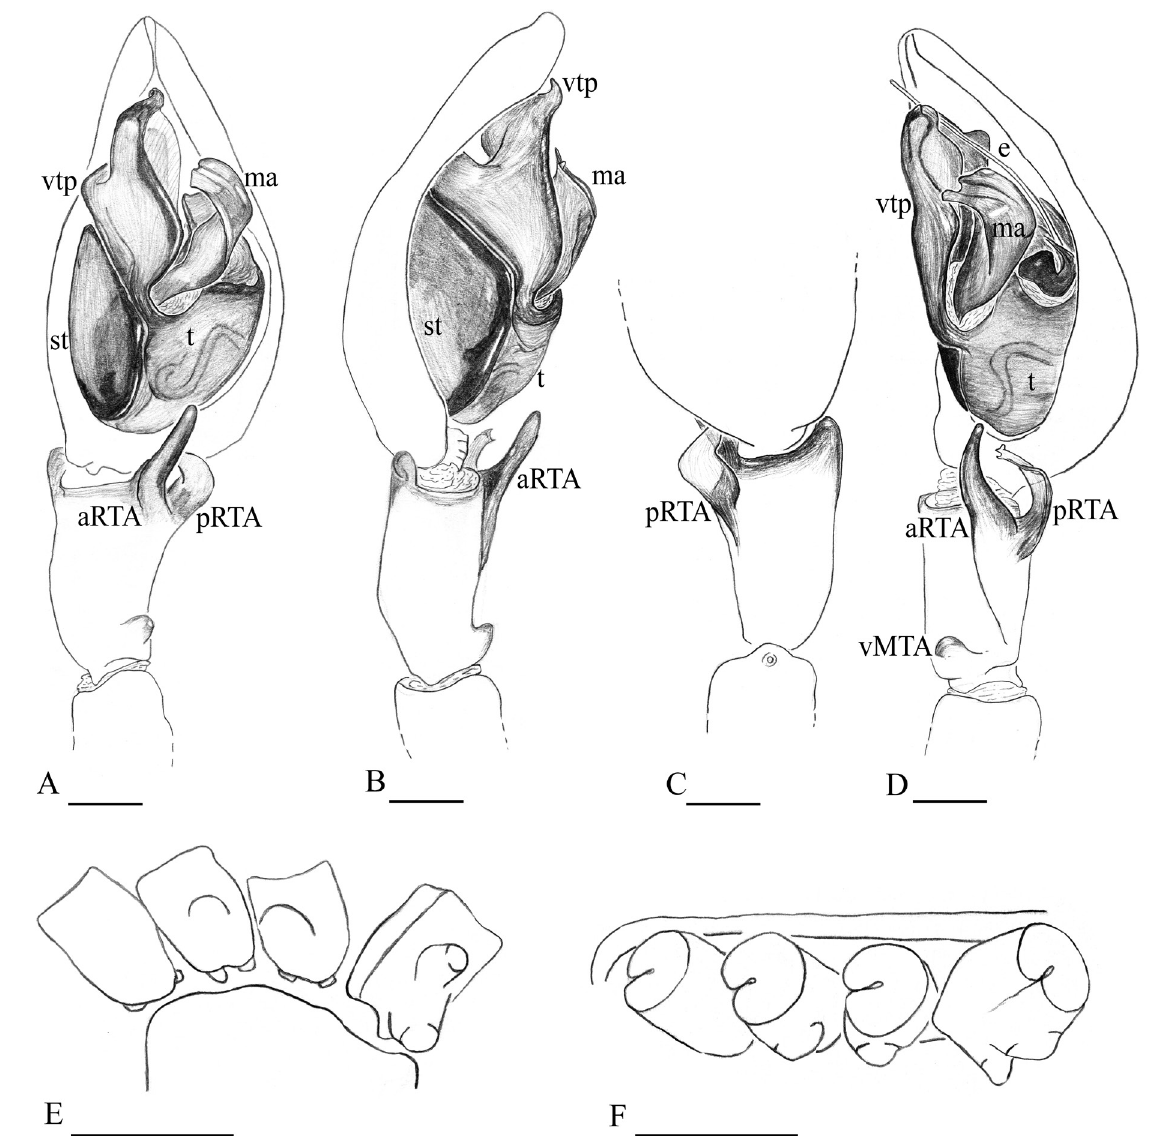
Fig. 51. Anyphaena stigma sp. nov., paratype, ♂ (CNAN-T01574). A . Pedipalp, ventral view. B . Pedipalp, prolateral view. C . Pedipalp, dorsal view. D . Pedipalp, retrolateral view. E . Coxae, ventral view. F . Coxae, lateral view. Scale bars: A–D = 0.2 mm; E–F = 1.0